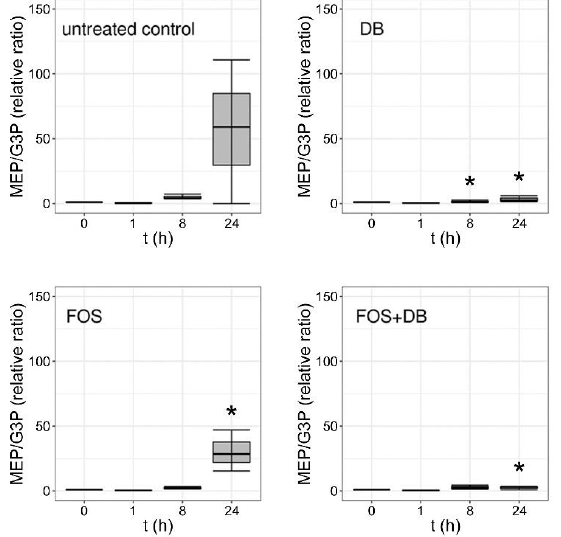
Figure 4. Relative MEP/G3P molar ratios in extracts at different times of P. falciparum cultures treated with 20 µM DB and fosmidomycin, individually and combined. *: p < 0.05.